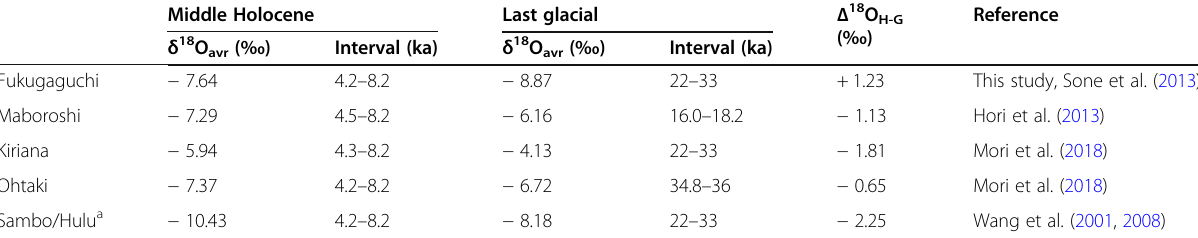
Table 2 Mean δ 18 O (vs VPDB) during mid-Holocene and the last glacial period recorded in Japanese and Chinese caves Middle